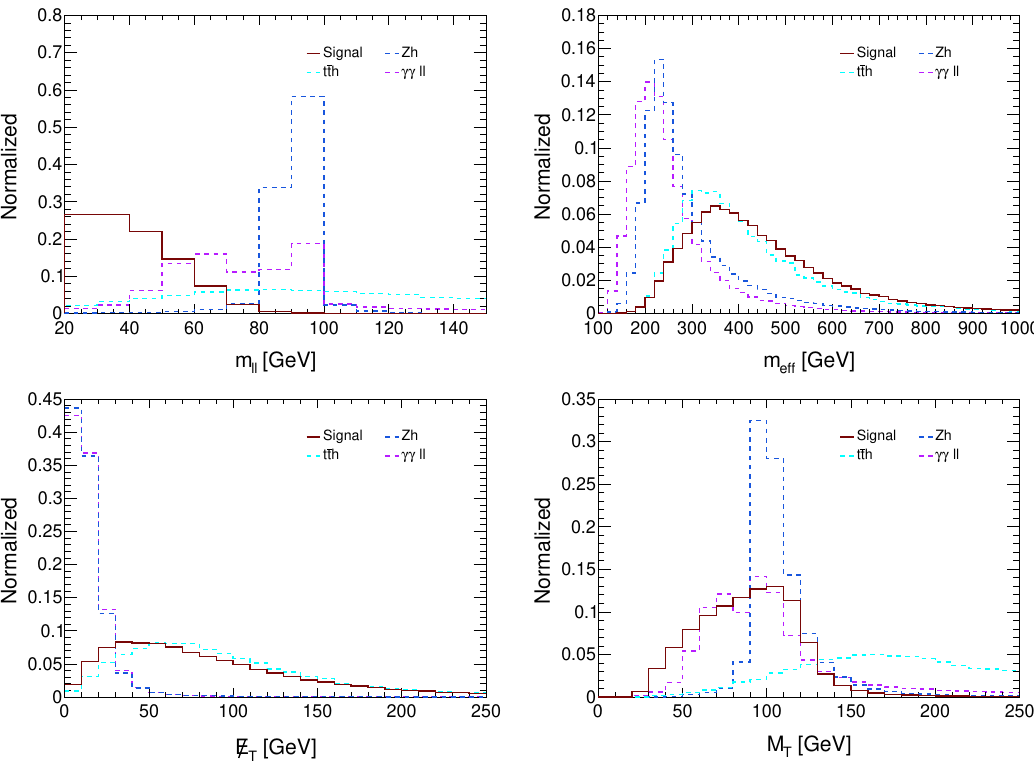
Figure 7 . Normalized distributions of m ‘‘ , m eff , /E and the dominant backgrounds after the application of acceptance cuts and generation level cuts.